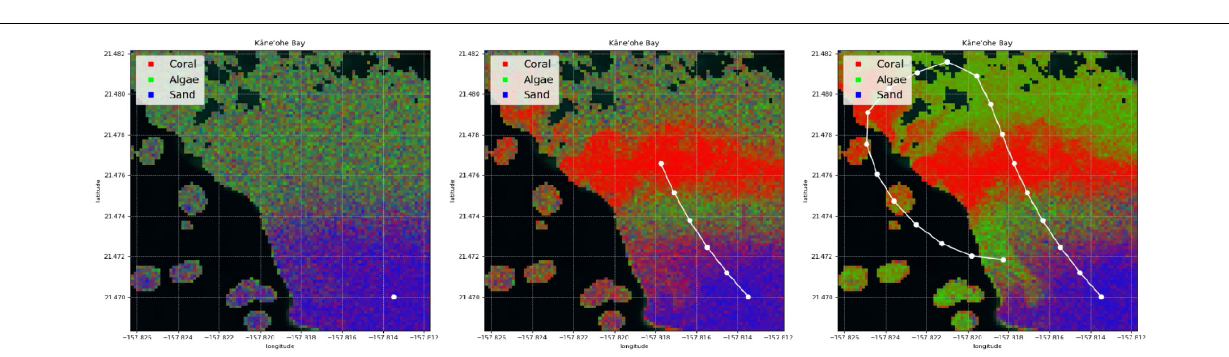
FIGURE 3 | Example of our active process for coral reef mapping applied in Kaneohe Bay, Hawaii. The CORAL mission focused on shallow water areas, and thus a mask (as shown in black areas) is applied for depths greater than 5 m within the subsetted scenes. Experience with the CORAL data suggests that the accuracy of the standard coral, algae, and sand estimation degrades below 5 m depth. For the purposes of this paper, we focus on shallow water areas with plenty of signal. The mapping process starts with poor predictions (left) . Just a few in situ samples are extrapolated throughout large areas with the assistance of remote sensing (center) . The predicted coral reef map improves as more samples are collected (right)